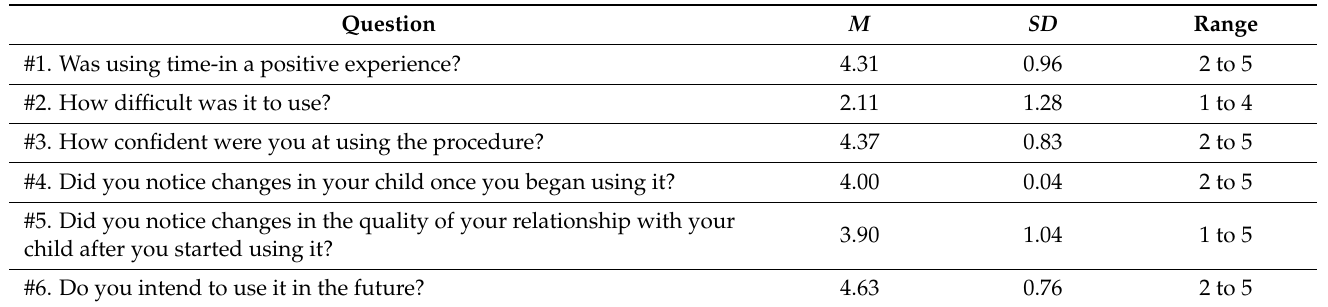
Table 2. Mothers’ views about time-in after using it for two